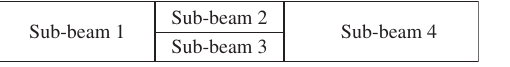
Figure 2 The delaminated beam is modeled by four interconnected